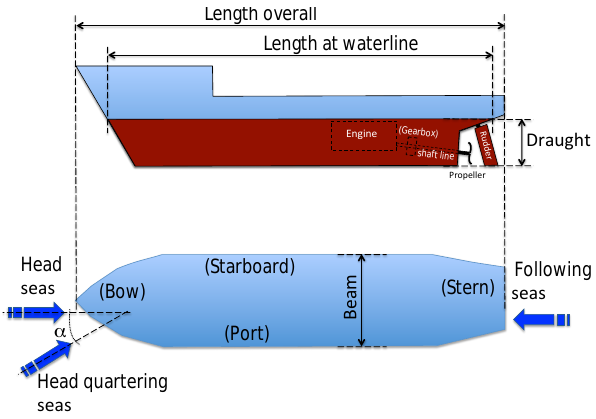
Figure 3. Main vessel dimensions and seaway nomenclature. The red part of the hull is normally underwater. The angle of wave en- counter α is related to the traditional ship heading parameter µ by µ π α = −